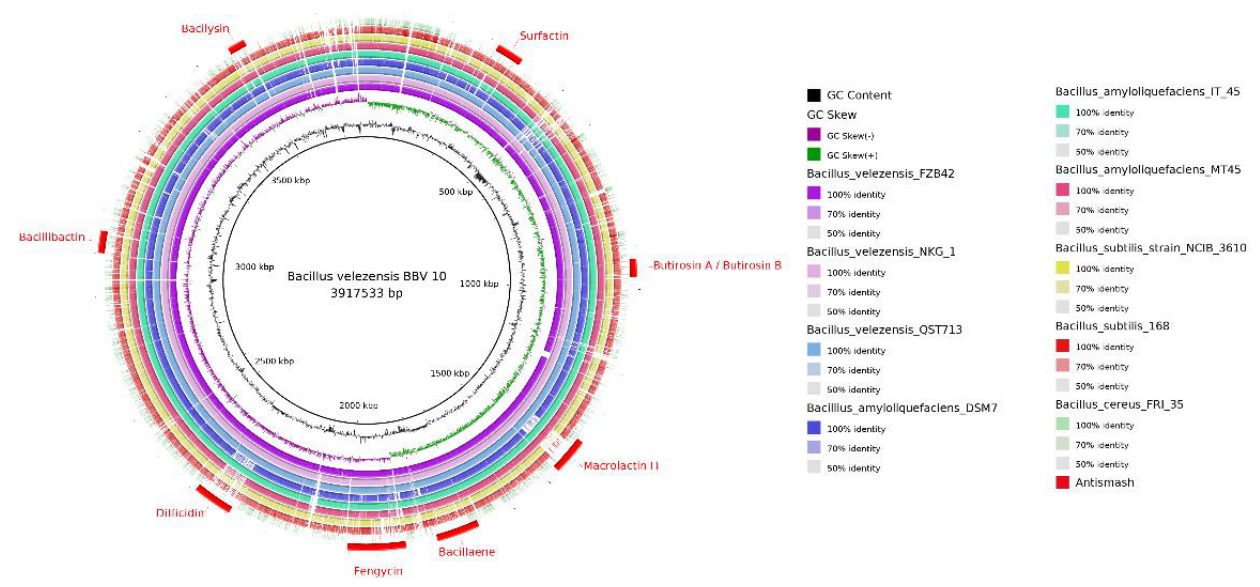
Figure 8. Circular representation of the genome of B. velezensis B.BV10 generated in the BRIG program.